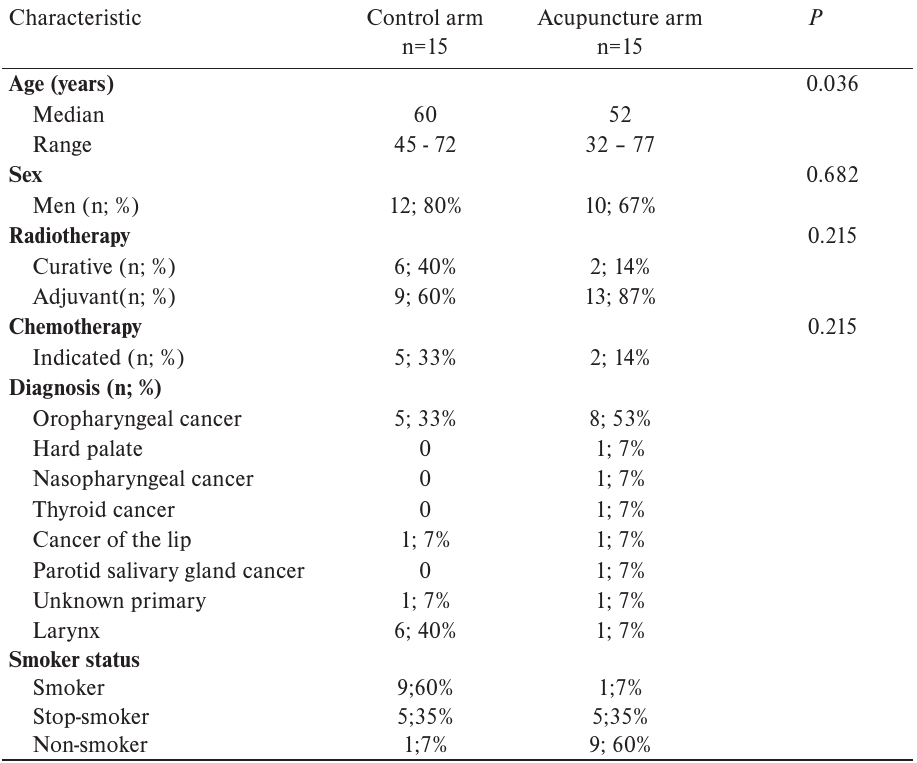
Table 1. Basic patients’